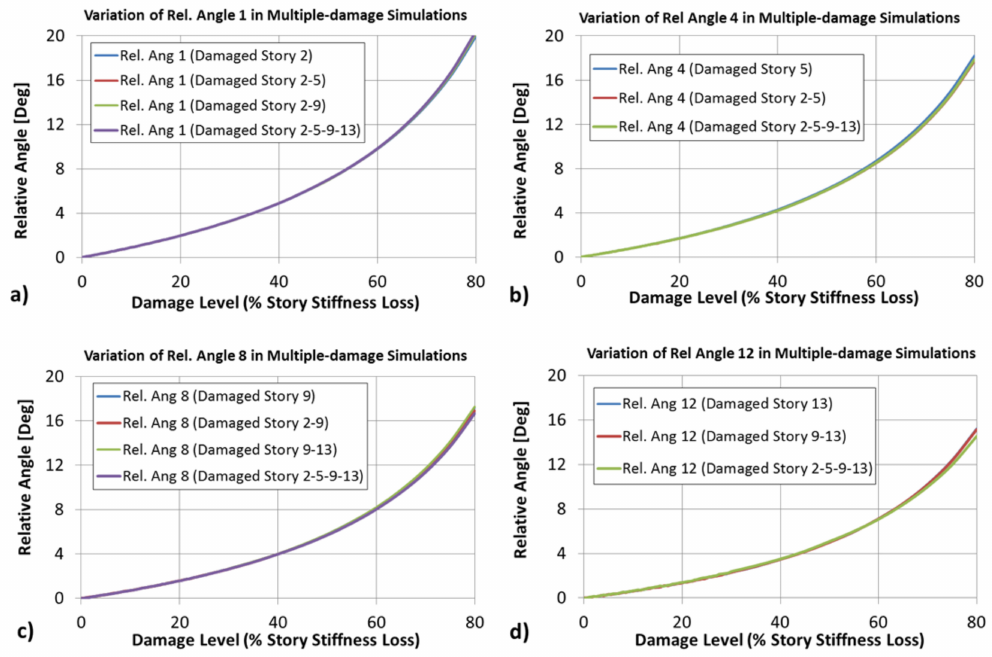
Figure 12. Relative angles calculated during concurrent damage on different floors ( a ) rel. ang.1 , ( b ) rel. ang.4 , ( c ) rel. ang.8 , ( d ) rel. ang.12 .